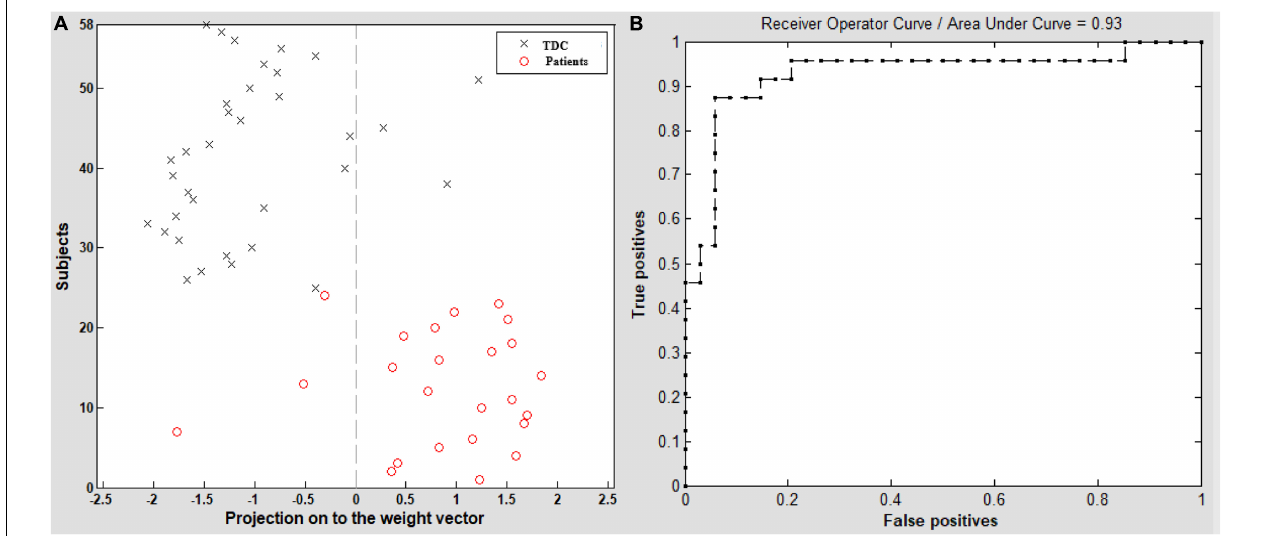
FIGURE 6 | A classification plot (A) and a receiver operating characteristic (ROC) curve (B) for the comparison between groups. VMHC maps of 24 children with GTCS and 34 TDC were used for classification, which yielded an accuracy of 89.34% (87.50% sensitivity, 91.18% specificity), statistically significant at p < 0.001. TDC, typically developing